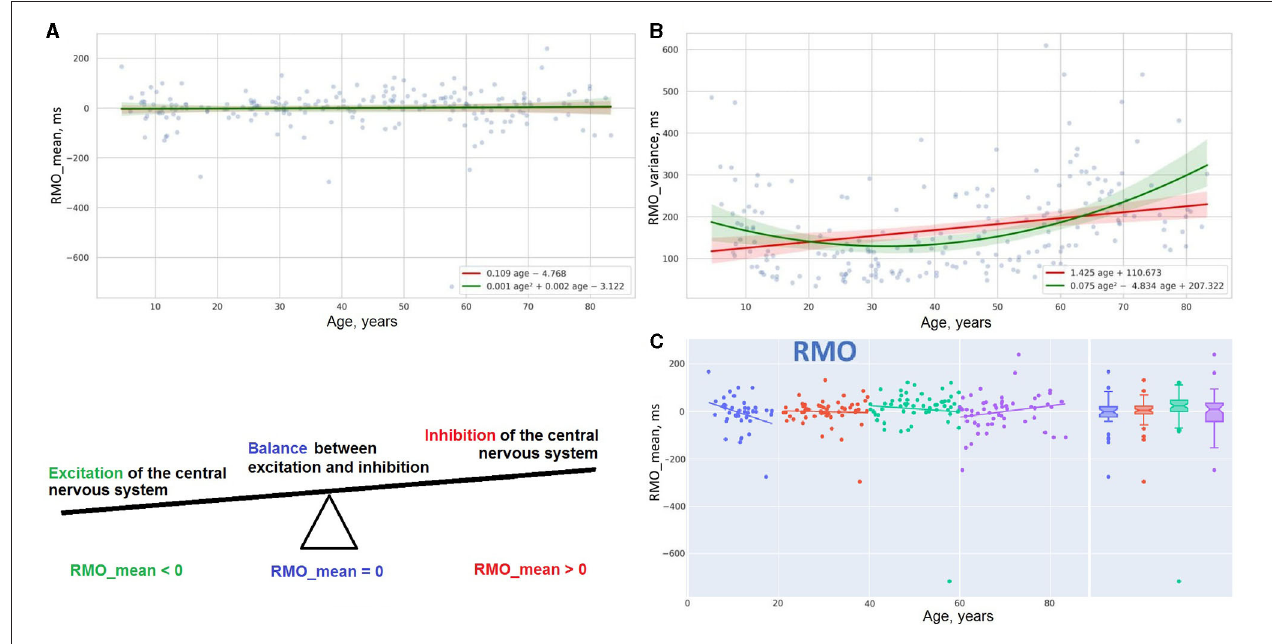
FIGURE 7 | Distribution of reaction time and its variance in RMO task (A,B) . Linear trendlines of performance in RMO task in age groups (C)